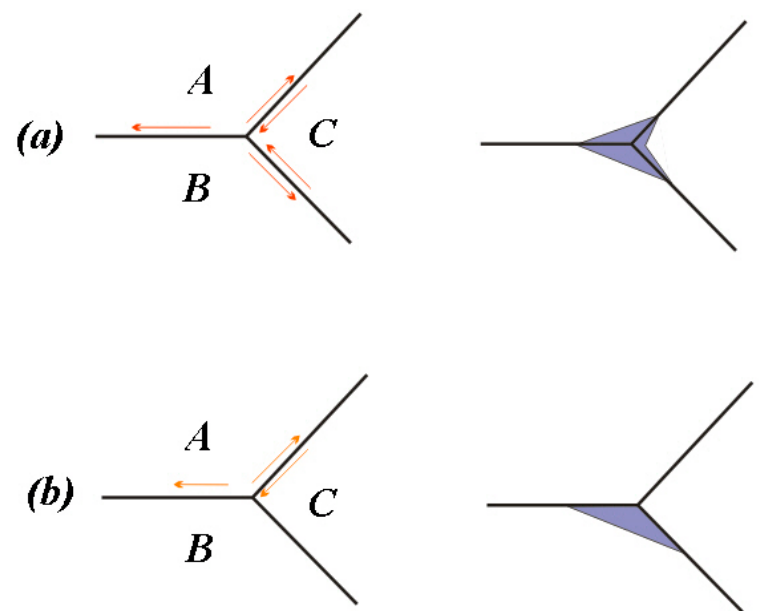
Figure 10. Illustration of the crack at the triple grain boundary junction of the crystal slip: ( a ) Slips on three grain boundaries; ( b ) Slips on two grain boundaries.